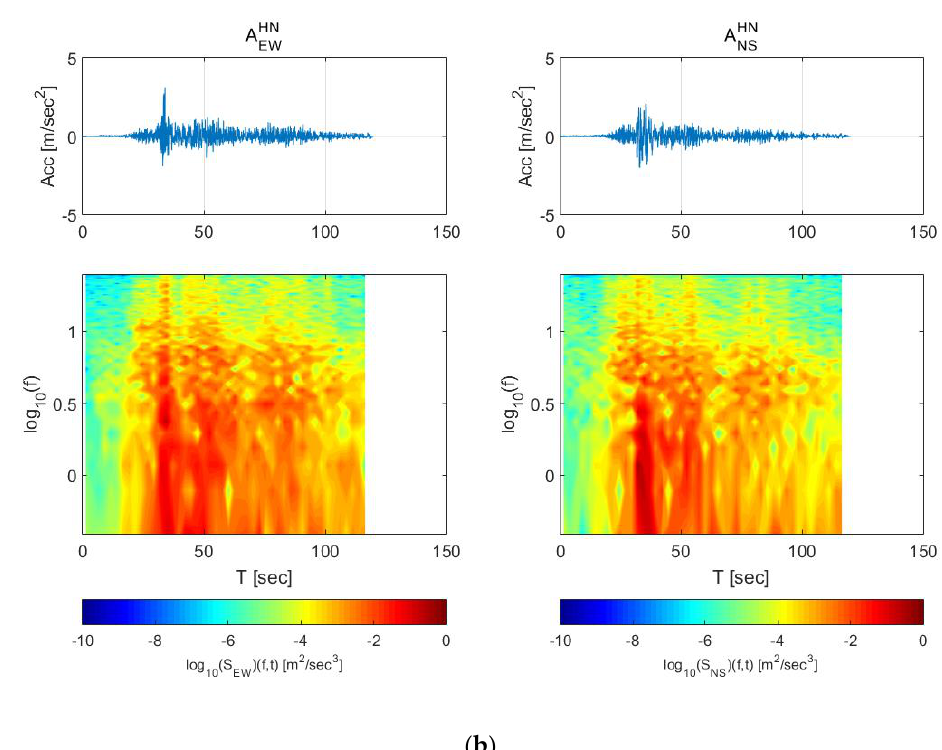
Figure 13. Spectral characteristics of the Hachinohe earthquake presented as ( a ) Power Spectral Density (PSD) and ( b ) spectrogram.